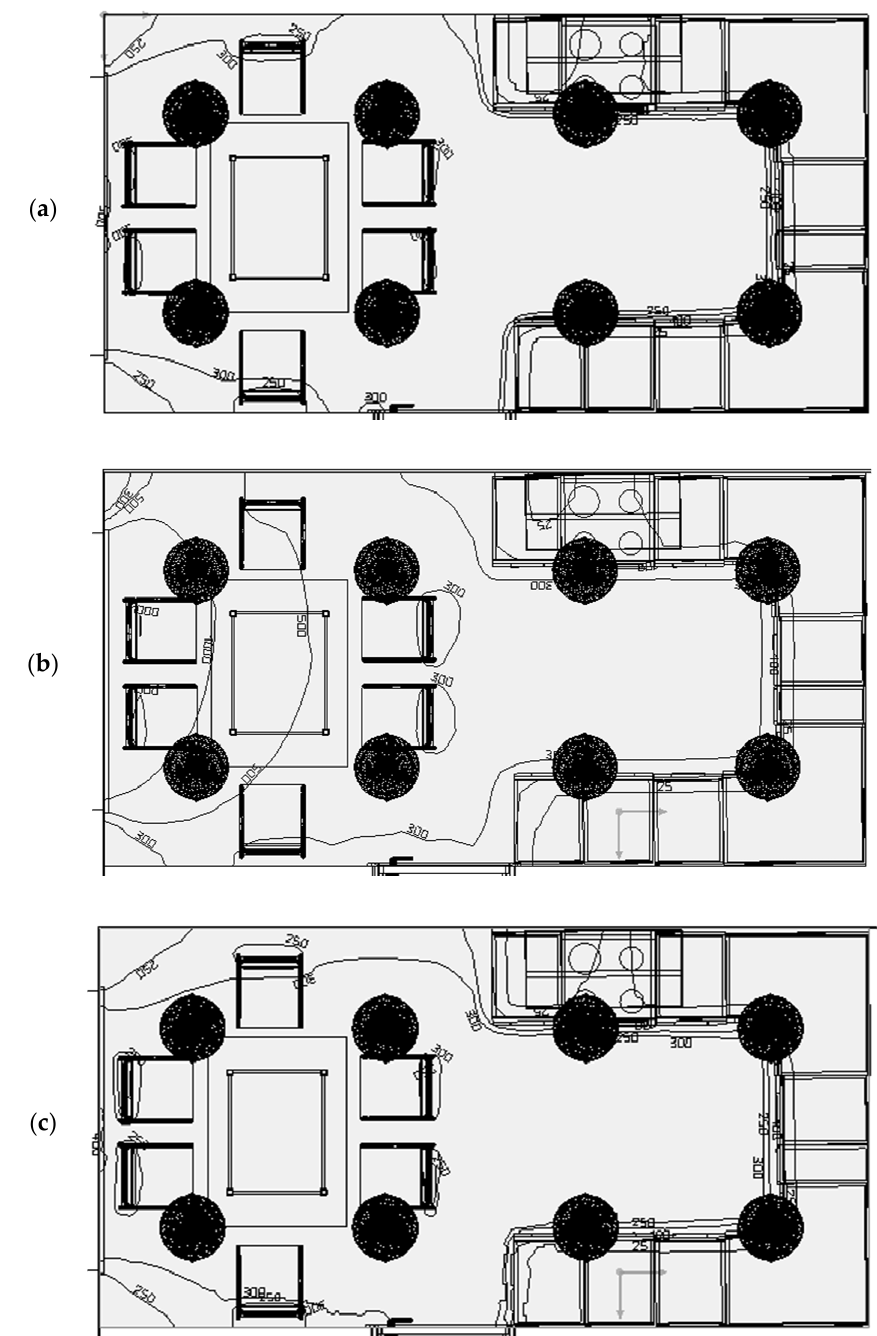
Figure A2. The even pattern of the simulation result from combining the artificial light of the smart adaptive lighting system for 300 lux illumination and the sunlight in DIALuxEvo 8.1 ( a ) at sub-scenario A, 6:00 a.m., 1 May 2019; ( b ) at sub-scenario B, 9:00 a.m., 5 June 2019; and ( c ) at sub-scenario C, 4:00 p.m., 10 November 2019.